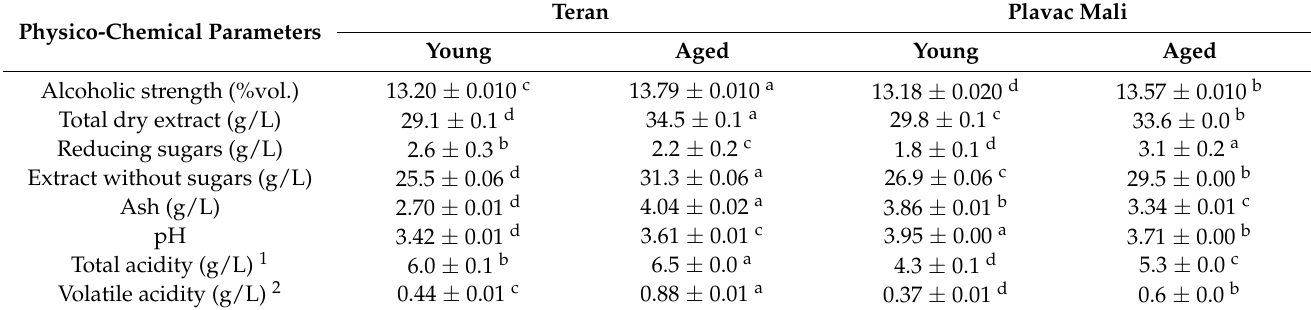
Table 2. Concentrations of standard physico-chemical analysis parameters of young and aged Teran and Plavac mali